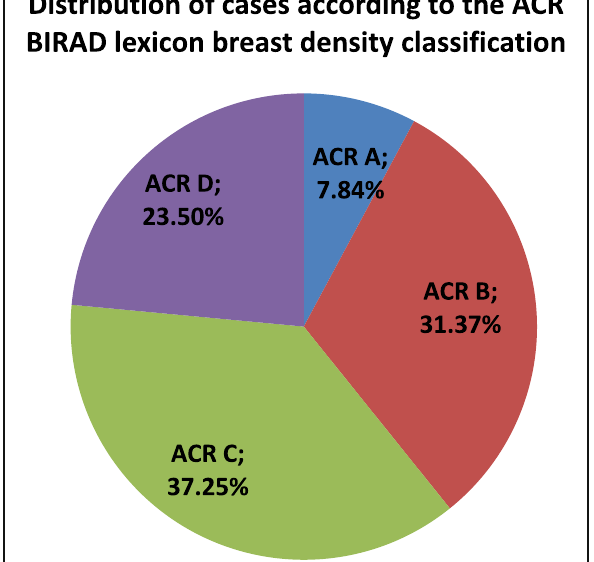
Fig. 1 Distribution of cases according to the ACR BIRADS lexicon breast density classification